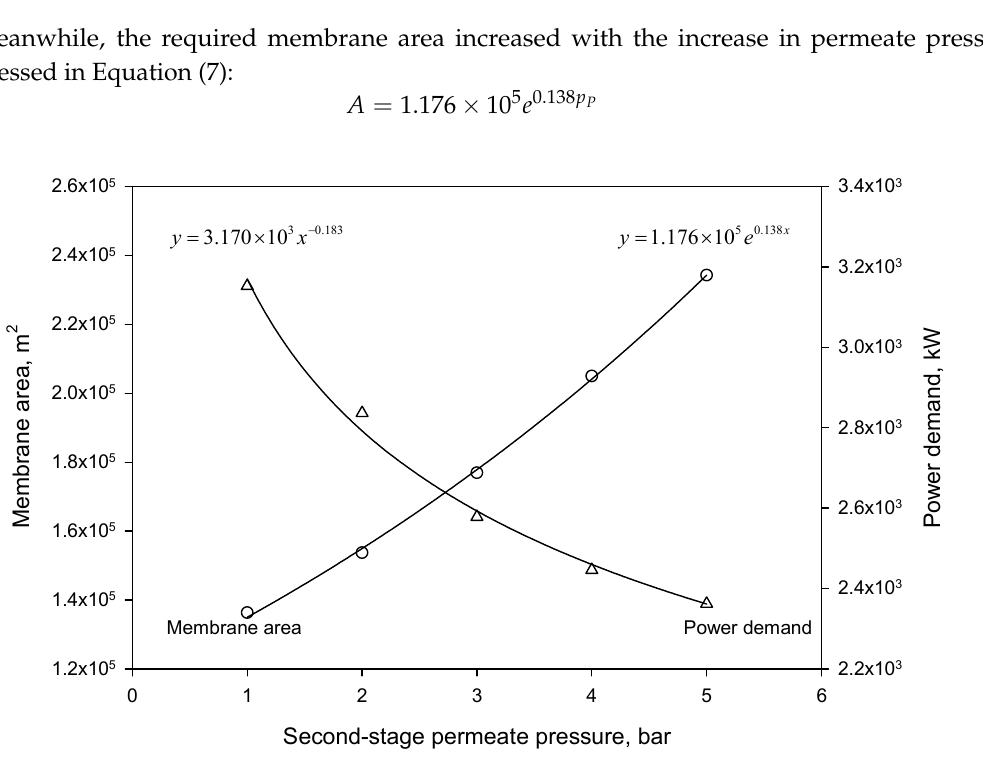
Figure 3. Dependence of required membrane area and power demand on the second-stage permeate pressure.